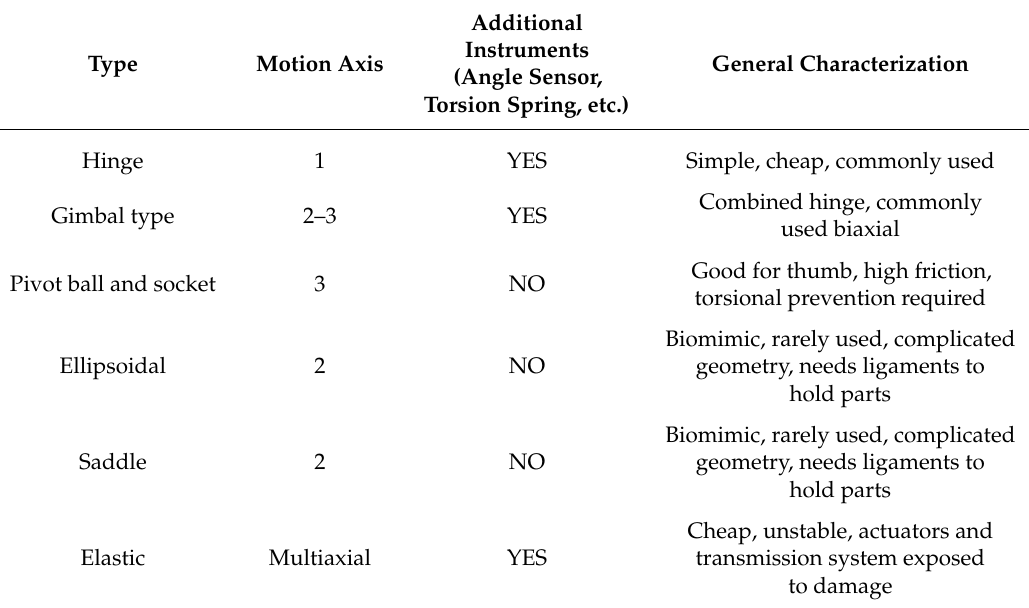
Table 1. Characteristics of main joint